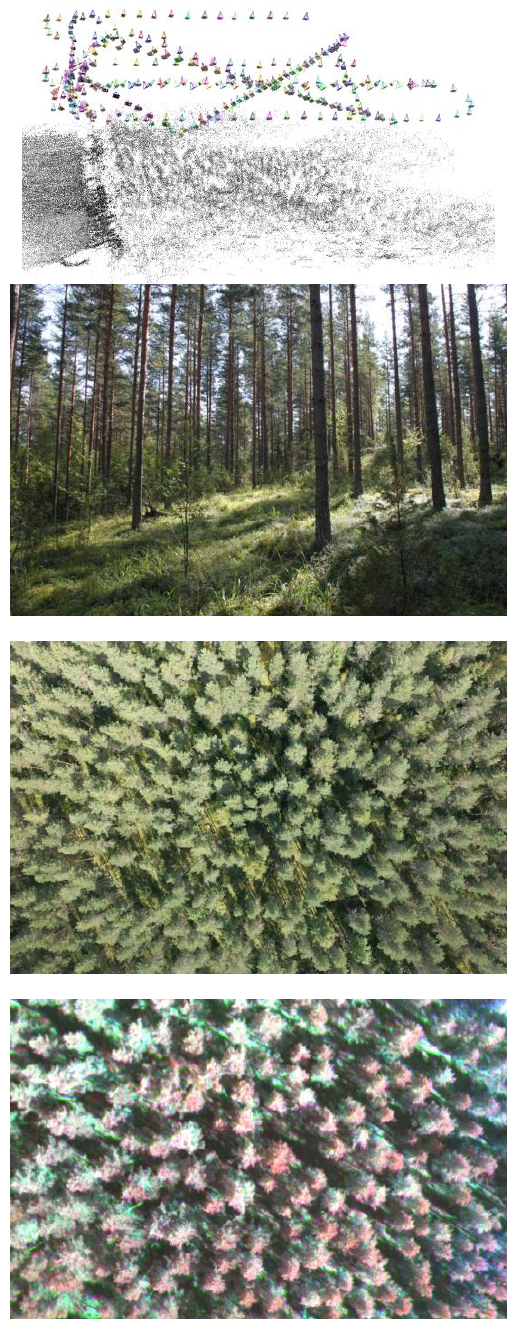
Figure 6. Traceable UAV campaign in Evo forestry test field. From top: the image block with four vertical flight lines and